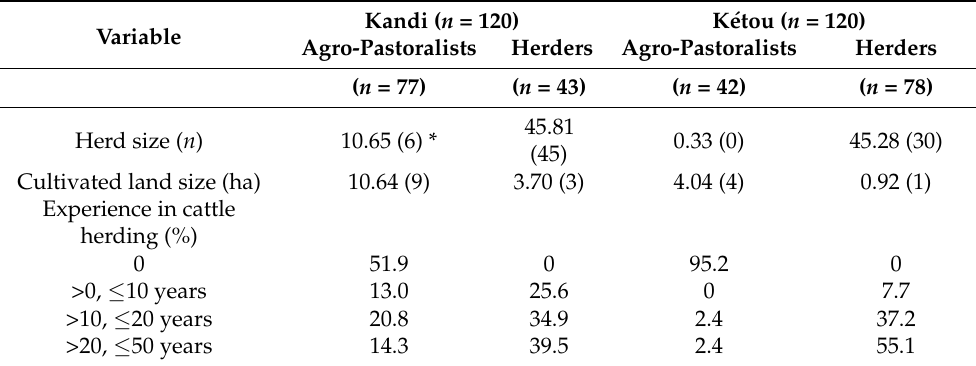
Figure 2. Simplified representation of the clusters obtained in northeastern (Kandi) and southeastern (K é tou) Benin. Table 1. Groups of farmers surveyed in the municipalities of Kandi (northeastern Benin, n = 120) and K é tou (southeastern Benin, n =